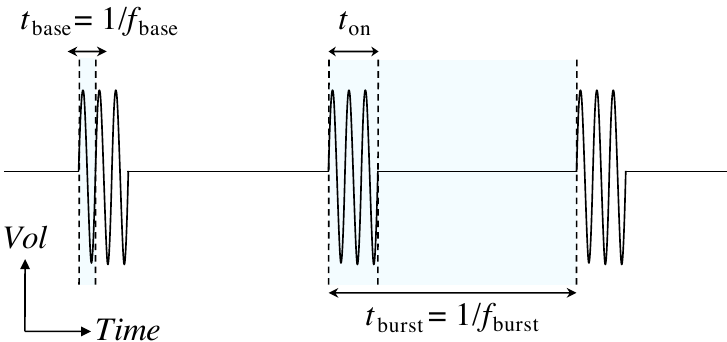
Figure 2. Alternating current (AC) voltage waveform for the burst